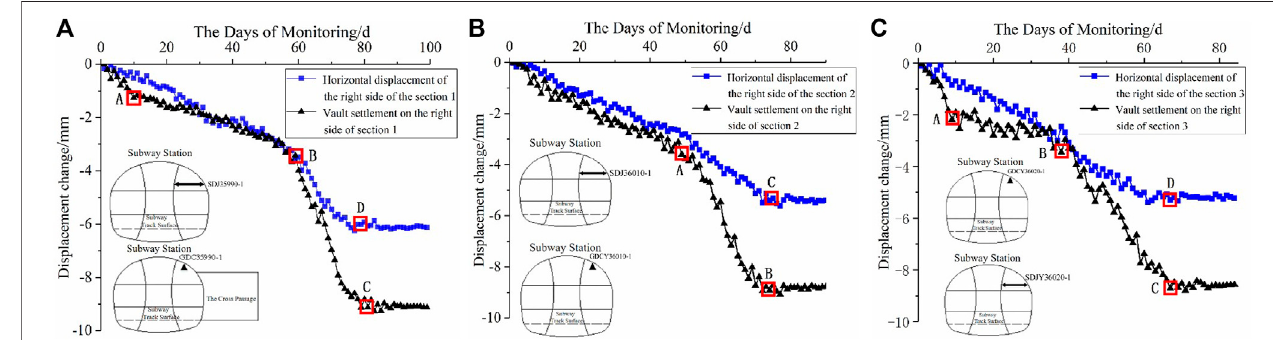
FIGURE 10 | Variation of displacement of the tunnel: (A) Section 1 , (B) Section 2 , and (C) Section 3 .